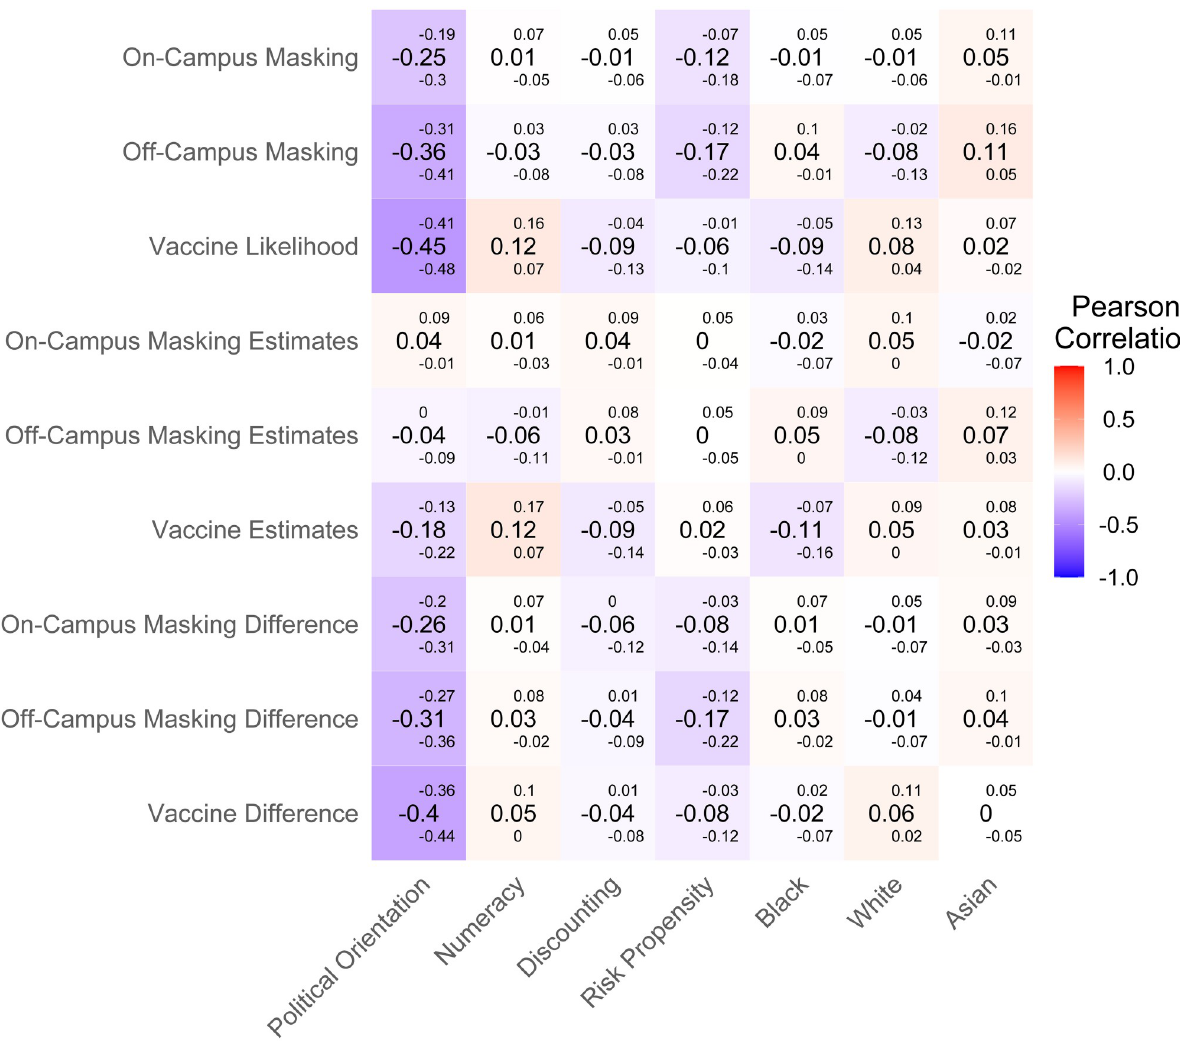
Fig 2. Zero-order correlations of outcome measures (behavioral estimations) and individual difference predictors. Both the Pearson correlation value and 95% credible intervals for the true value are shown. Darker red panels indicate stronger positive correlations, while darker blue panels indicate stronger negative